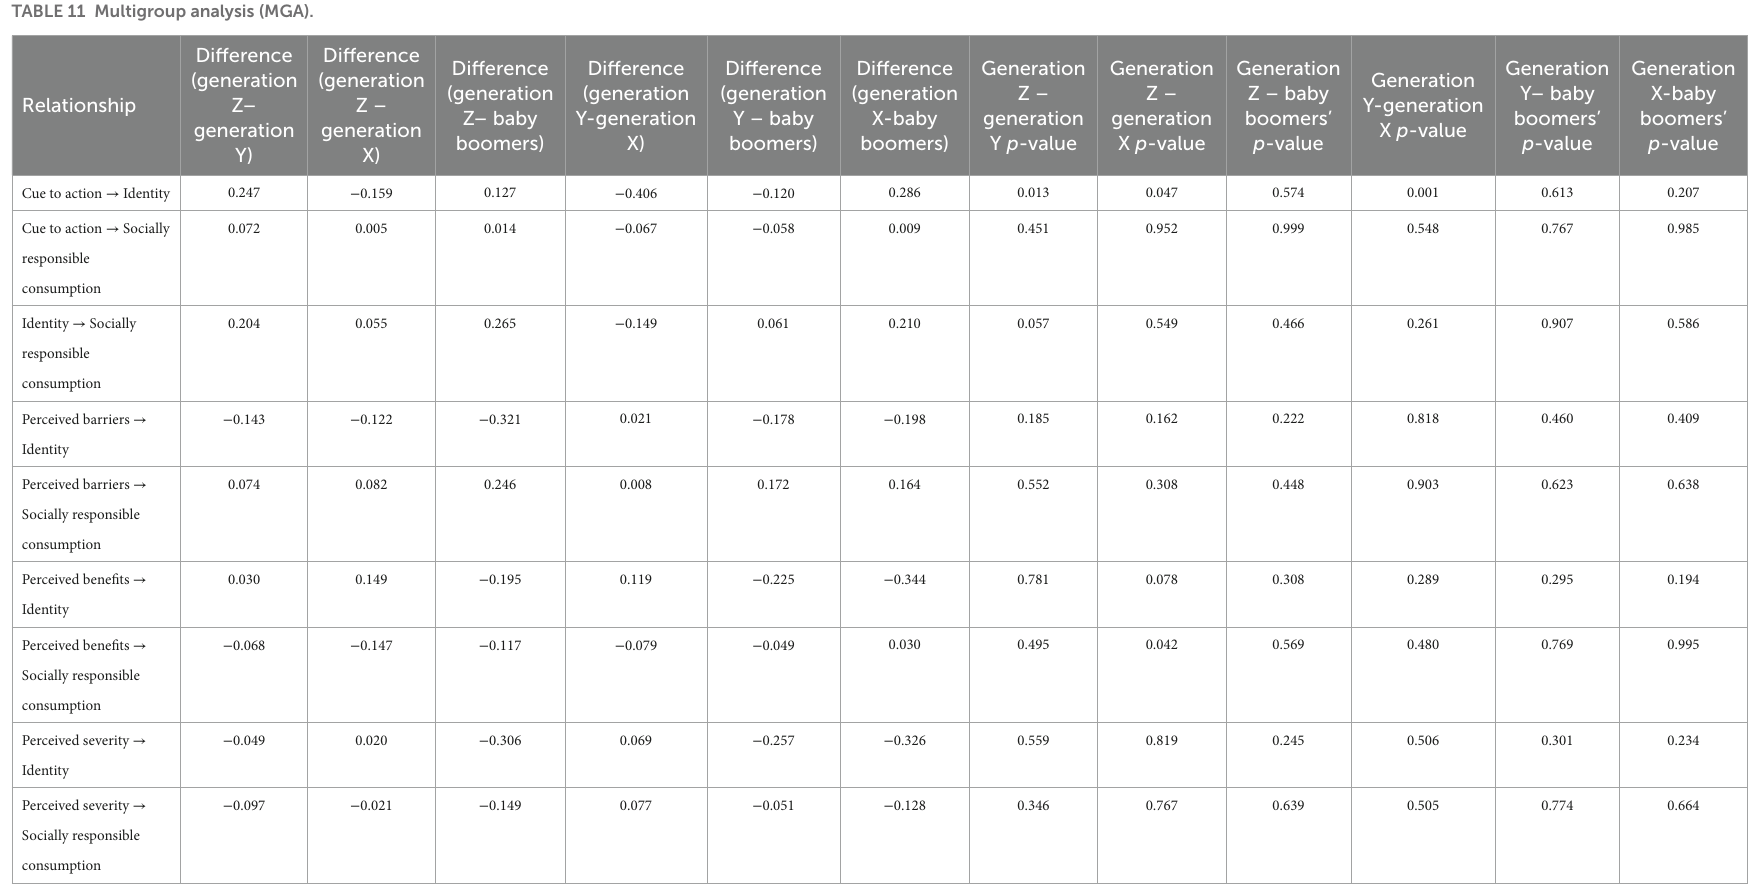
TABLE 11 Multigroup analysis